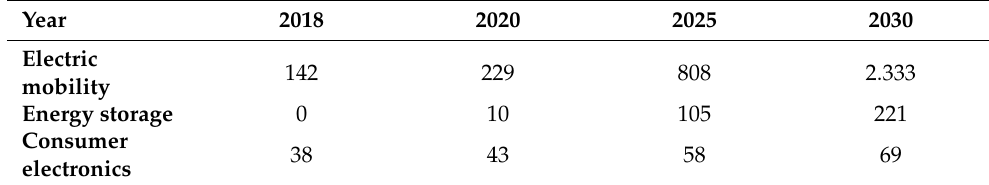
Table A1. Global battery demand by application in GWh for the year 2030, WEF base case